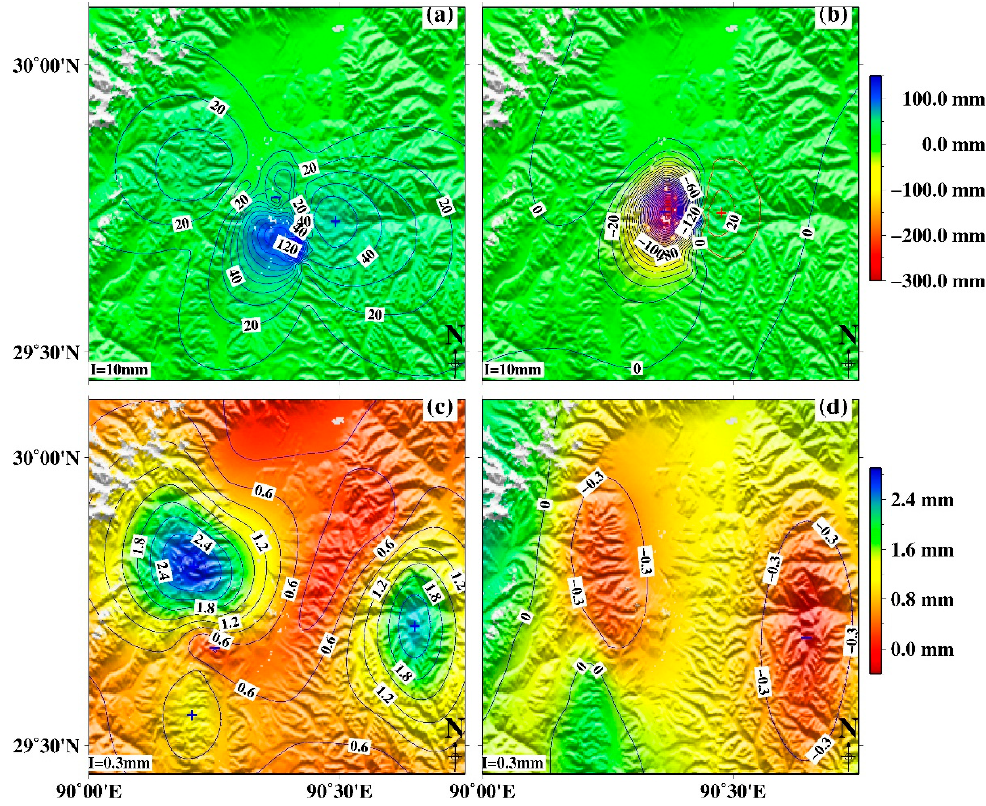
Figure 7. Contour maps of coseismic surface displacements and differences between models with Poisson’s ratio of 0.25 and 0.3. The contour interval is shown at the bottom left corner. ( a ) Horizontal coseismic surface displacements estimated from the model with Poisson’s ratio of 0.25; ( b ) Differences between horizontal displacements of models with Poisson’s ratio of 0.25 and 0.3; ( c ) Vertical coseismic surface displacements estimated from the model with Poisson’s ratio of 0.25; ( d ) Differences between vertical displacements of models with Poisson’s ratio of 0.25 and